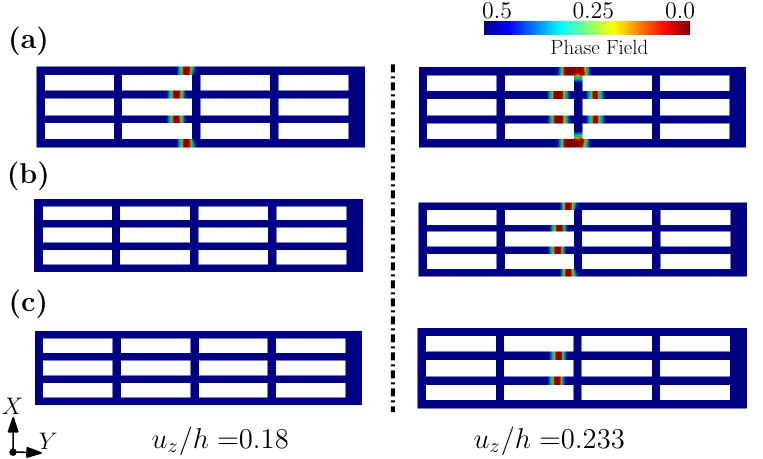
Figure 13. The contour plots of phase field with different G c / ( µ h ) =: ( a ) 0.1 × 10 − 3 ; ( b ) 0.2 × 10 − 3 ; ( c ) 0.3 × 10 − 3